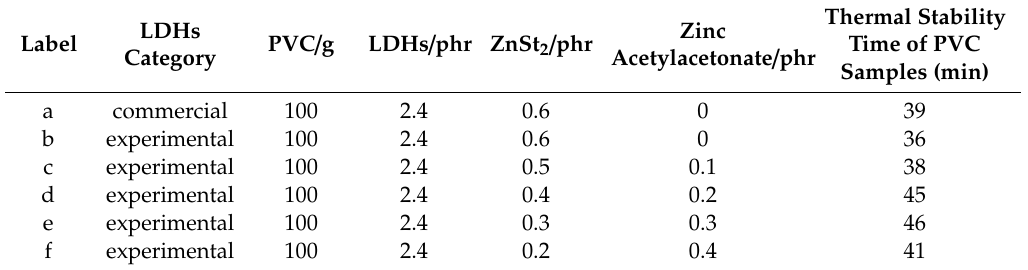
Table 3. The result of Congo red test of zinc acetylacetonate added to the PVC